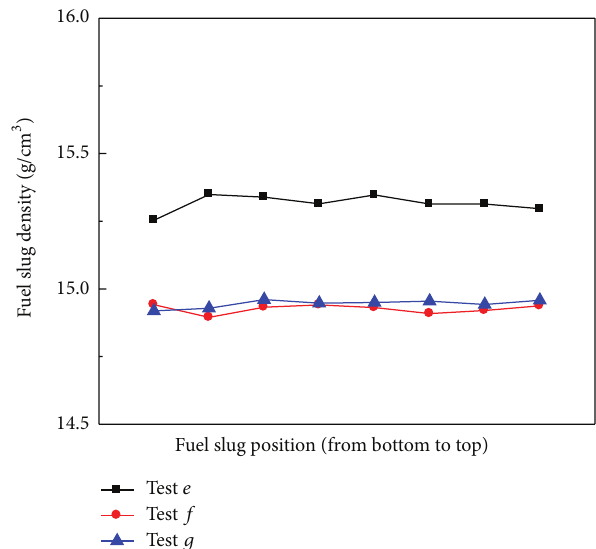
Figure 5: Distributions of fuel slug density according to the position of fuel